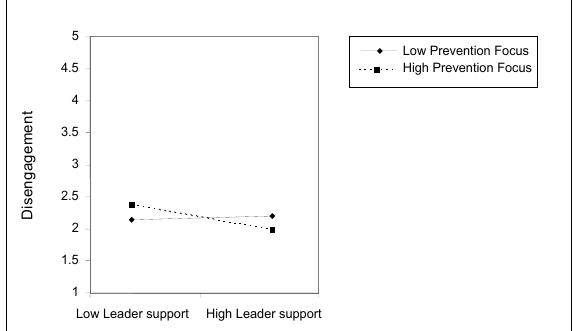
FIGURE 7 Prevention focus moderating the relationship between participation and openness to change in sample 1